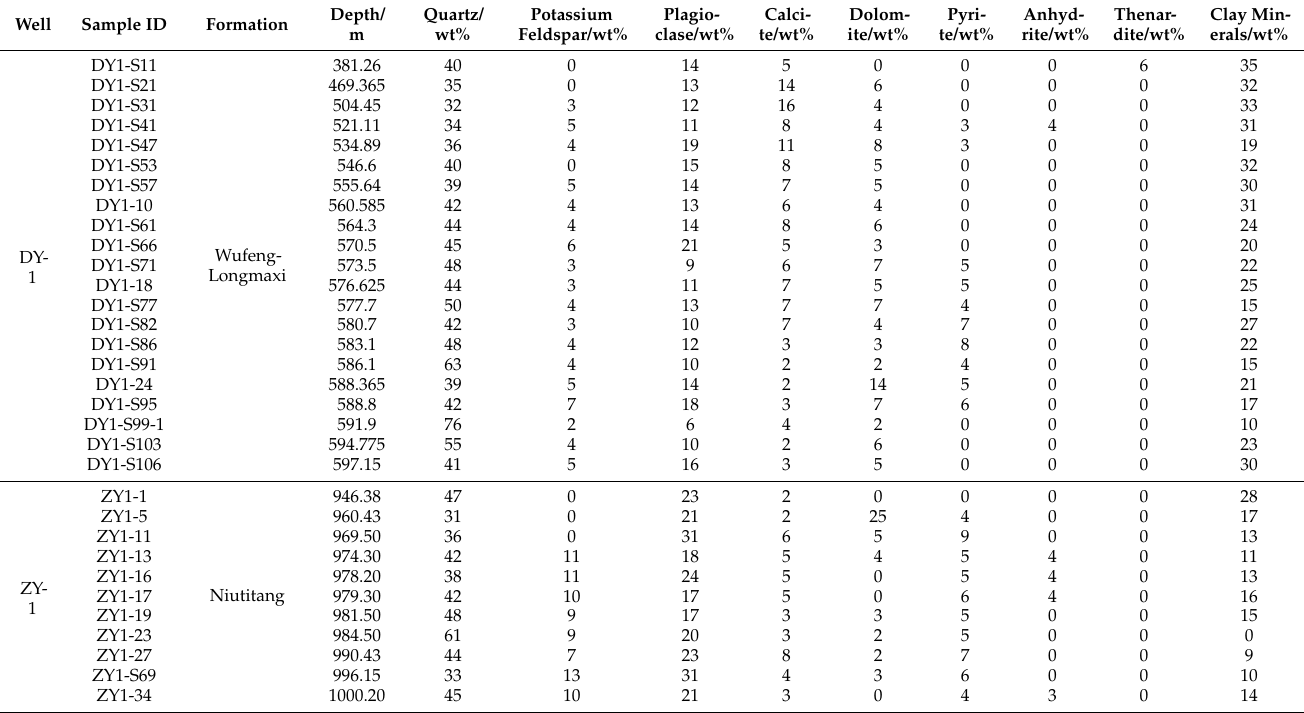
Table 3. Mineral compositions and contents of the Wufeng-Longmaxi and Niutitang Formations in northern Guizhou Province.